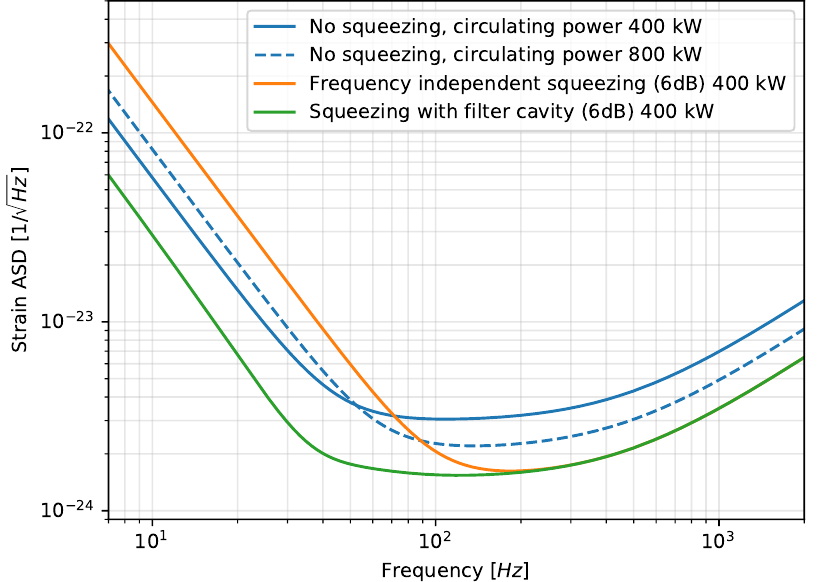
Figure 1. Quantum noise, given in terms of equivalent gravitational-wave detector sensitivity, in the Advanced LIGO design configuration (other noises not shown), calculated using [17]. Gravitational- wave detectors are sensitive to strain, change in arm length over the total arm length. At frequencies above 200 Hz, shot noise is the dominant quantum noise while radiation pressure dominates below 50 Hz. The addition of frequency independent squeezing can reduce one type of quantum noise while increasing the other (see Section 2). Once other noise sources are reduced enough that radiation pressure dominates the low frequency sensitivity of an interferometer, injecting frequency indepen- dent squeezing will degrade the sensitivity at some frequencies. Reflecting the squeezed field off of a filter cavity can rotate and filter the squeezing in a frequency dependent way to achieve a broadband sensitivity improvement. The parameters of the injected squeezing, losses, and filter cavity are chosen here so that there is 6 dB of shot noise reduction, and 8 dB of increase in quantum radiation pressure without a filter cavity, and 6 dB improvement in quantum radiation pressure noise with a filter